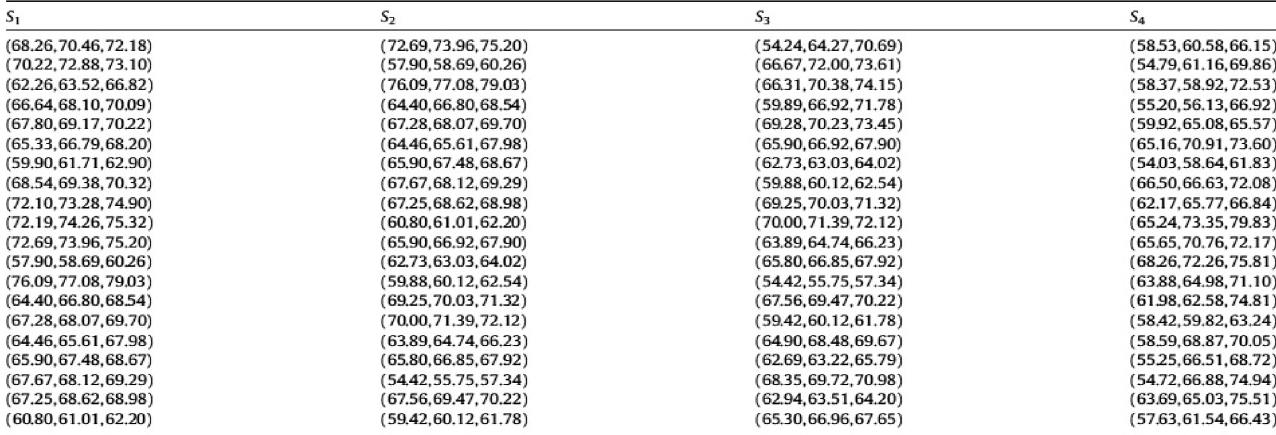
Table 1. Triangular fuzzy data collected from